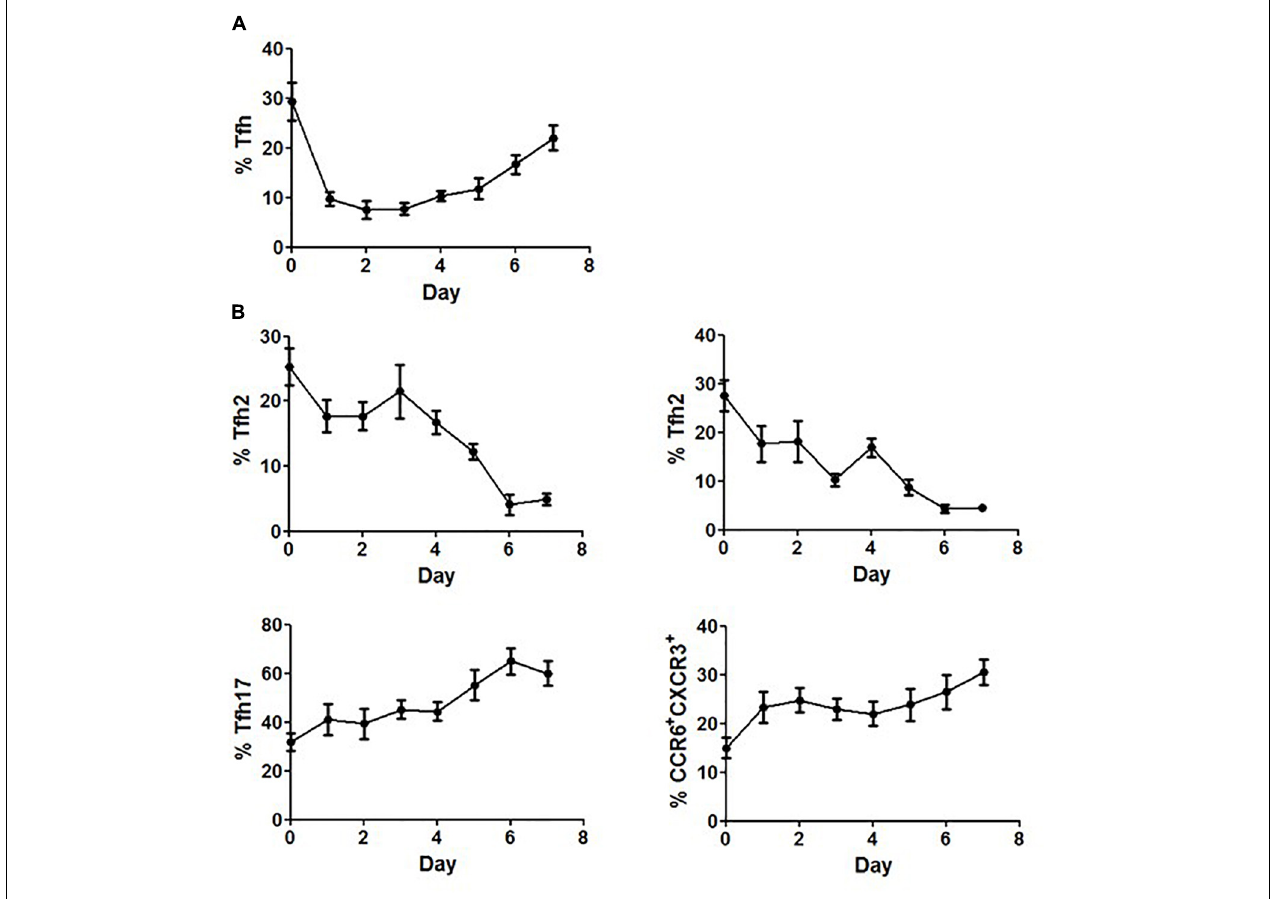
FIGURE 6 | Restoration of Tfh cells after prolonged stimulation with methylprednisolone. (A) Circulating Tfh cells from healthy controls were measured daily for up to 7 days after adding 20 mg/mL of methylprednisolone. (B) Circulating Tfh subsets from healthy controls were measured daily for up to 7 days after adding 20 mg/mL of methylprednisolone. All results are presented as mean ± standard error of the mean